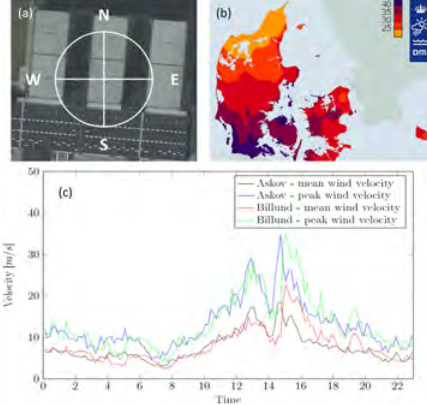
Figure 1. (a) Cardinal points ( Google Earth [2], modified), (b) distribution of the peak wind velocity in Denmark during hurricane "Christian" in October 2013 ( Danmark Meteorologiske Institut [3], modified) and (c) measurements of the wind velocities at stations near to the building.